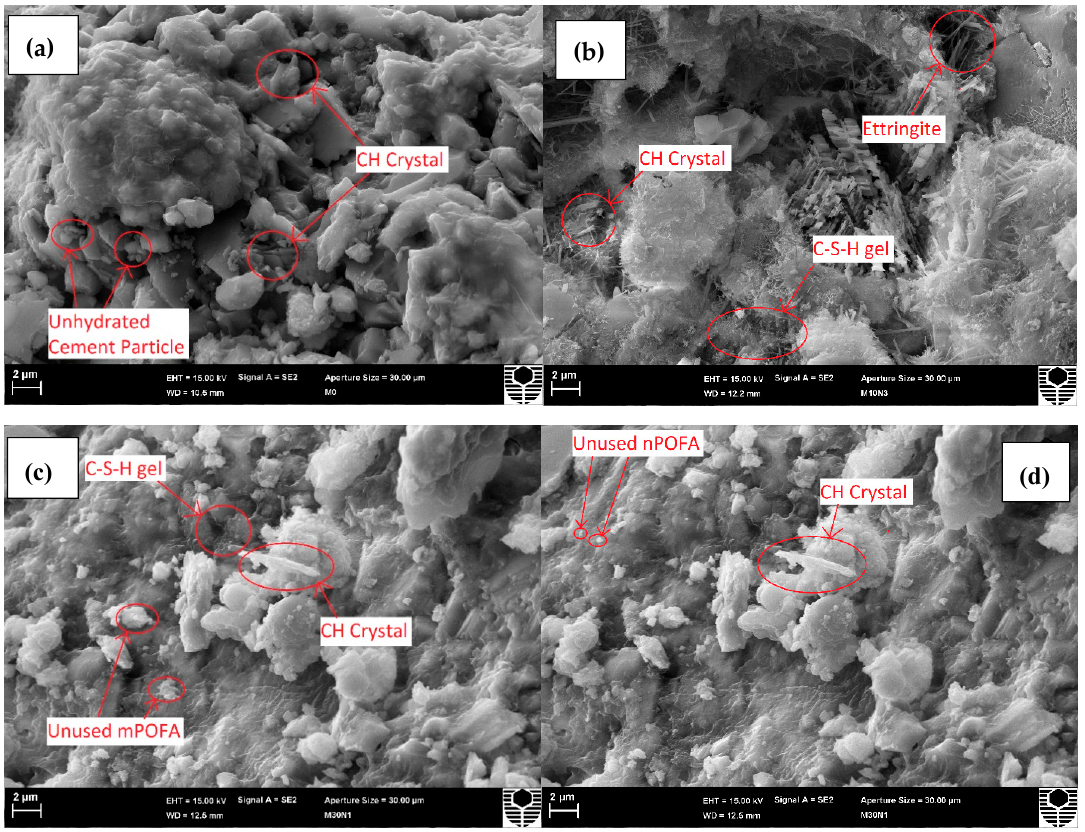
Figure 8. Microstructure of M0 ( a ) M10N3 ( b ) M30N1 ( c ) and M30N3 ( d ) after 28 days of curing. Table 6. Average size (nm) of crystals present in different mixtures.